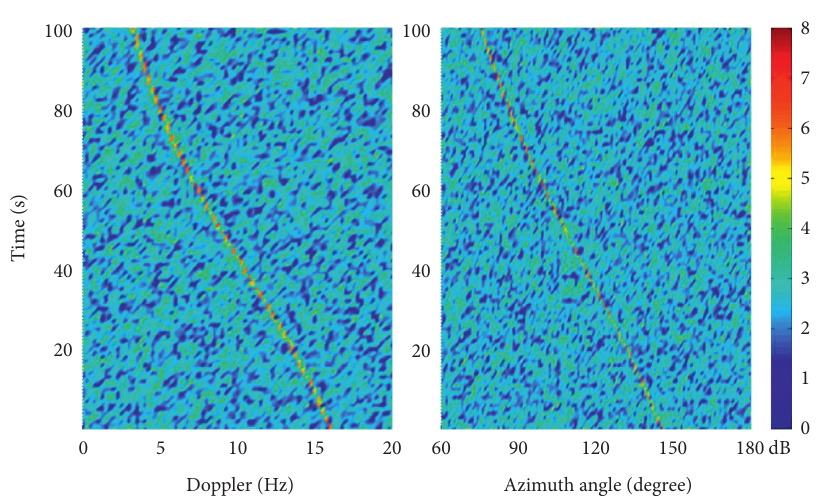
Figure 8: The time-doppler and time-azimuth traces of simulation data.